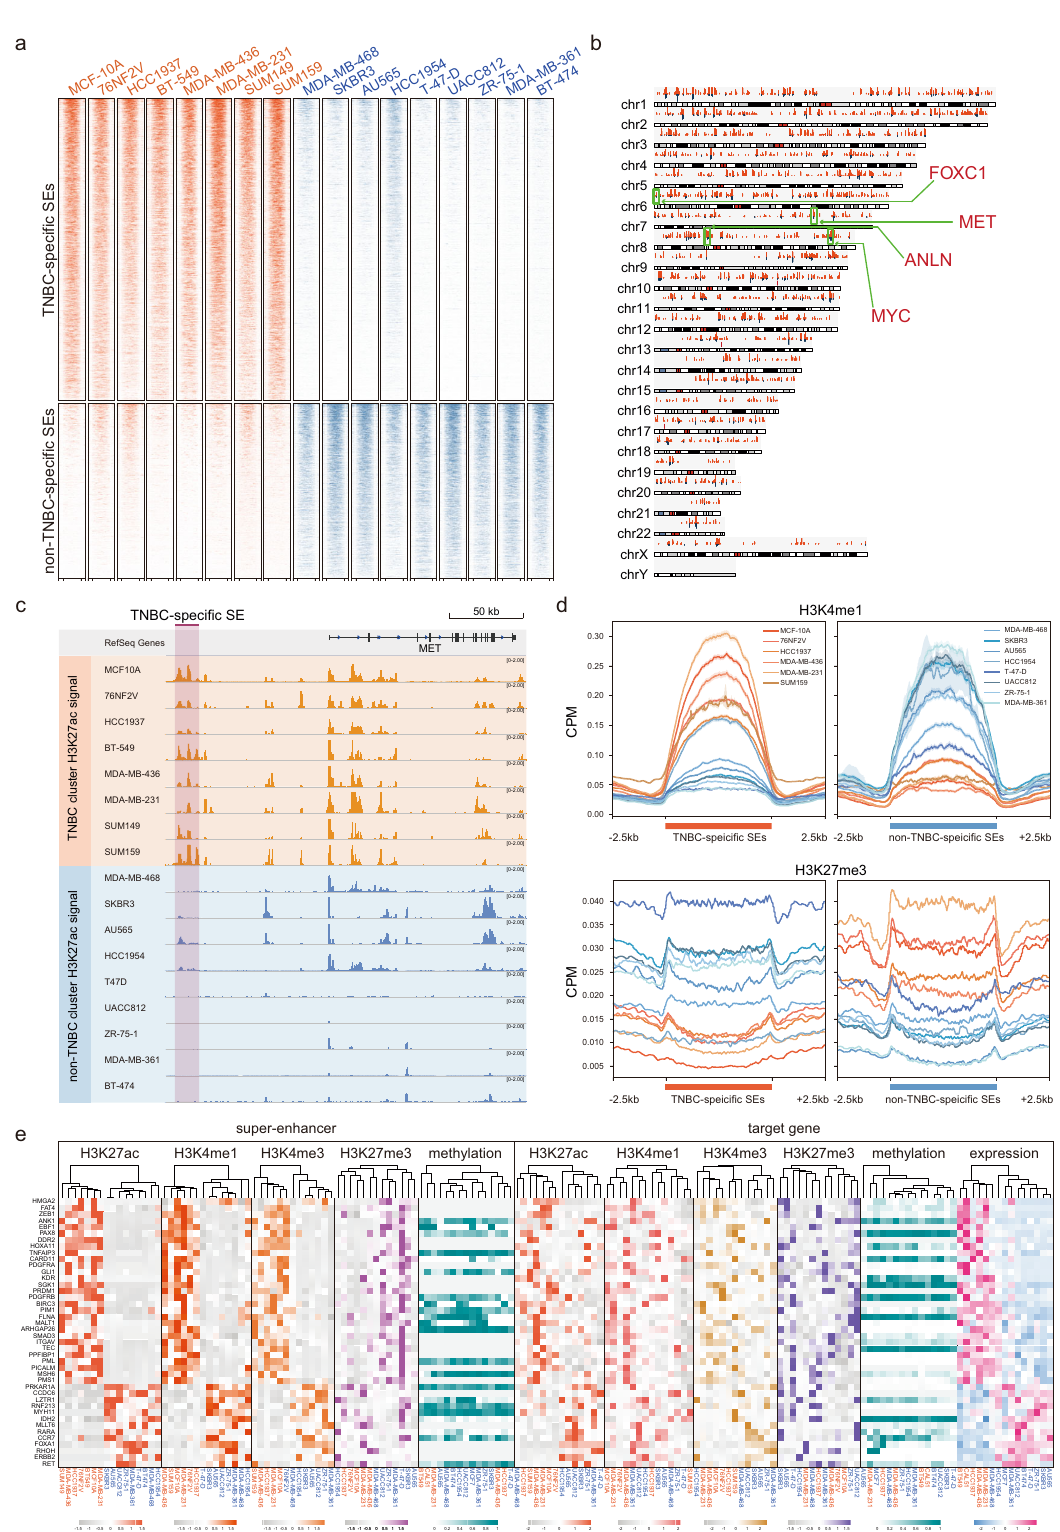
Fig. 2 Multiomic characterization of subtype-speci fi c super-enhancers. a Heatmap compares H3K27ac enrichment patterns between TNBC-speci fi c SEs and non-TNBC-speci fi c SEs across TNBC and non-TNBC cell lines. b A genome-wide overview of the loci and co-occurrence frequencies of identi fi ed TNBC-speci fi c SEs in TNBC cell lines. Oncogenes FOXC1, MET and MYC were indicated. c Genome browser plot illustrates TNBC-speci fi c SE detected in the upstream region of MET. d Higher enrichment of H3K4me1 signals was observed in TNBC-speci fi c SEs in TNBC cell lines than non-TNBC cell lines, whereas H3K27me3 signals were depleted in TNBC-speci fi c SEs in TNBC cell lines. e Heatmaps illustrate gene expression, DNA methylation, H3K27ac, H3K4me1, H3K4me3, H3K27me3 patterns of cancer-related genes in TNBC cell lines compared to non-TNBC cell lines. In each heatmap, the cell lines were organized by hierarchical clustering, with labels colored in orange and blue highlighting TN lines and non-TNBC lines, respectively.